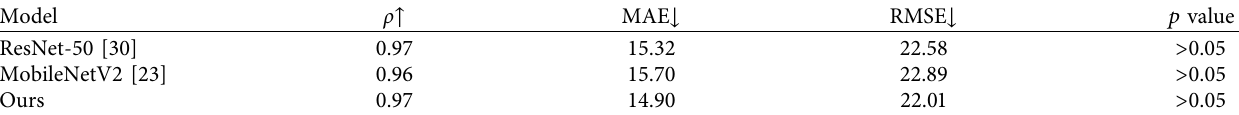
Table 5: Results of models with transfer learning on our dataset.